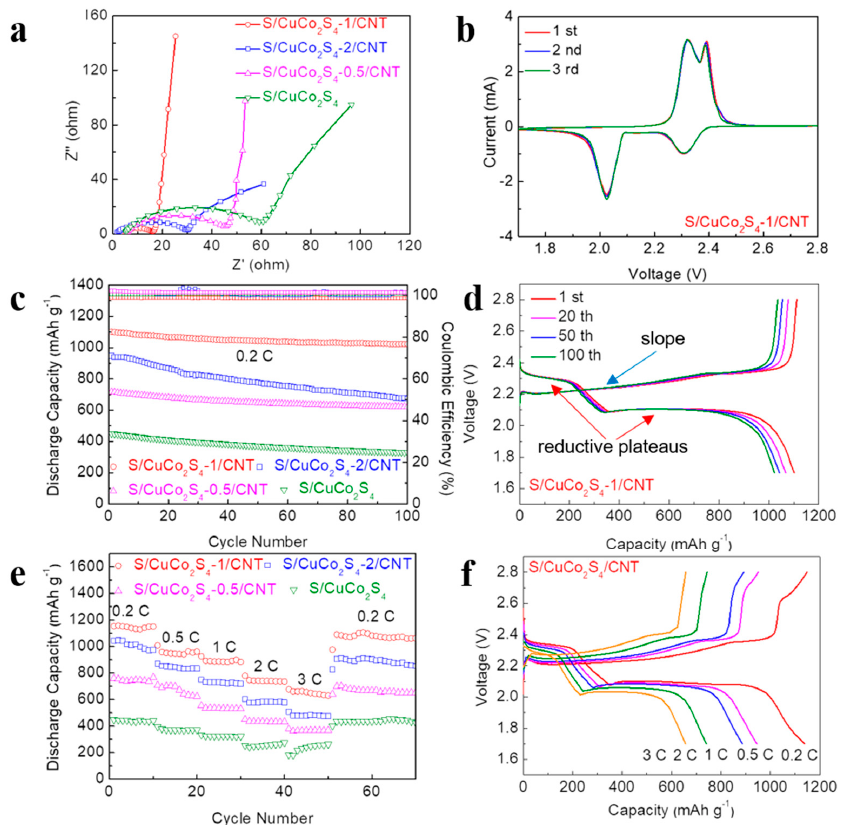
Figure 5. ( a ) Nyquist plots of S/CuCo 2 S 4 , S/CuCo 2 S 4 -0.5/CNT, S/CuCo 2 S 4 -1/CNT and S/CuCo 2 S 4 -2/CNT cathodes before cycling. ( b ) CV curves at the scan rate of 0.1 mV s − 1 of S/CuCo 2 S 4 -1/CNT cathodes. ( c ) Cycling performances of S/CuCo 2 S 4 , S/CuCo 2 S 4 -0.5/CNT, S/CuCo 2 S 4 -1/CNT and S/CuCo 2 S 4 -2/CNT cathodes at 0.2 C. ( d ) Charge/discharge voltage profiles of S/CuCo 2 S 4 -1/CNT at 0.2 C. ( e ) Rate performances of S/CuCo 2 S 4 , S/CuCo 2 S 4 -0.5/CNT, S/CuCo 2 S 4 -1/CNT and S/CuCo 2 S 4 -2/CNT cathodes. ( f ) Charge/discharge voltage profiles at 0.2 C, 0.5 C, 1 C, 2 C and 3 C of S/CuCo 2 S 4 -1/CNT.